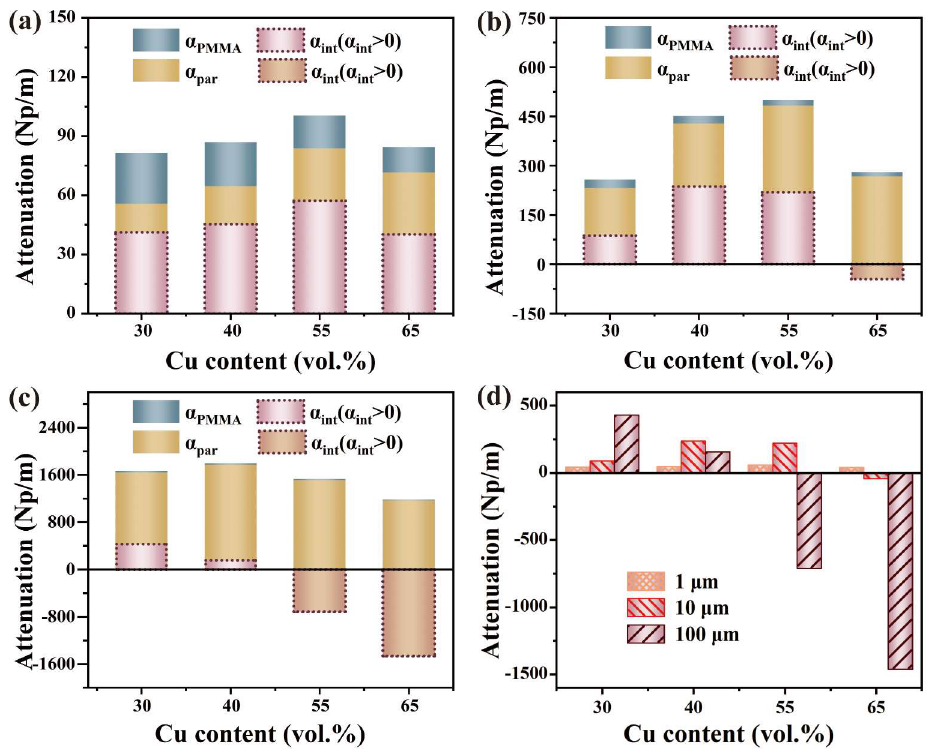
Figure 7. Each component of attenuation: ( a ) 1 µ m Cu/PMMA; ( b ) 10 µ m Cu/PMMA; ( c ) 100 µ m Cu/PMMA; and ( d ) particle interaction of 1, 10, 100 µ m Cu/PMMA. At 0.4 µs, the stress distribution of the elastic wave propagation in the sample is shown in Figure 8a. The stress direction aligned almost perfectly with the initial loading stress wave, and the influence of the particle interaction was negligible. The aftershock occurred after an initial stress wave loading of 1.2 µs, as shown in Figure 8b. The direction of stress propagation in the aftershocks caused by particle interactions is disorderly. The blue and red colors represent tensile and compressive waves, respectively, and the yellow arrows indicate the direction of stress propagation. To emphasize the direction of stress propagation, the arrows in Figure 8a,b were enlarged because the intensity of the